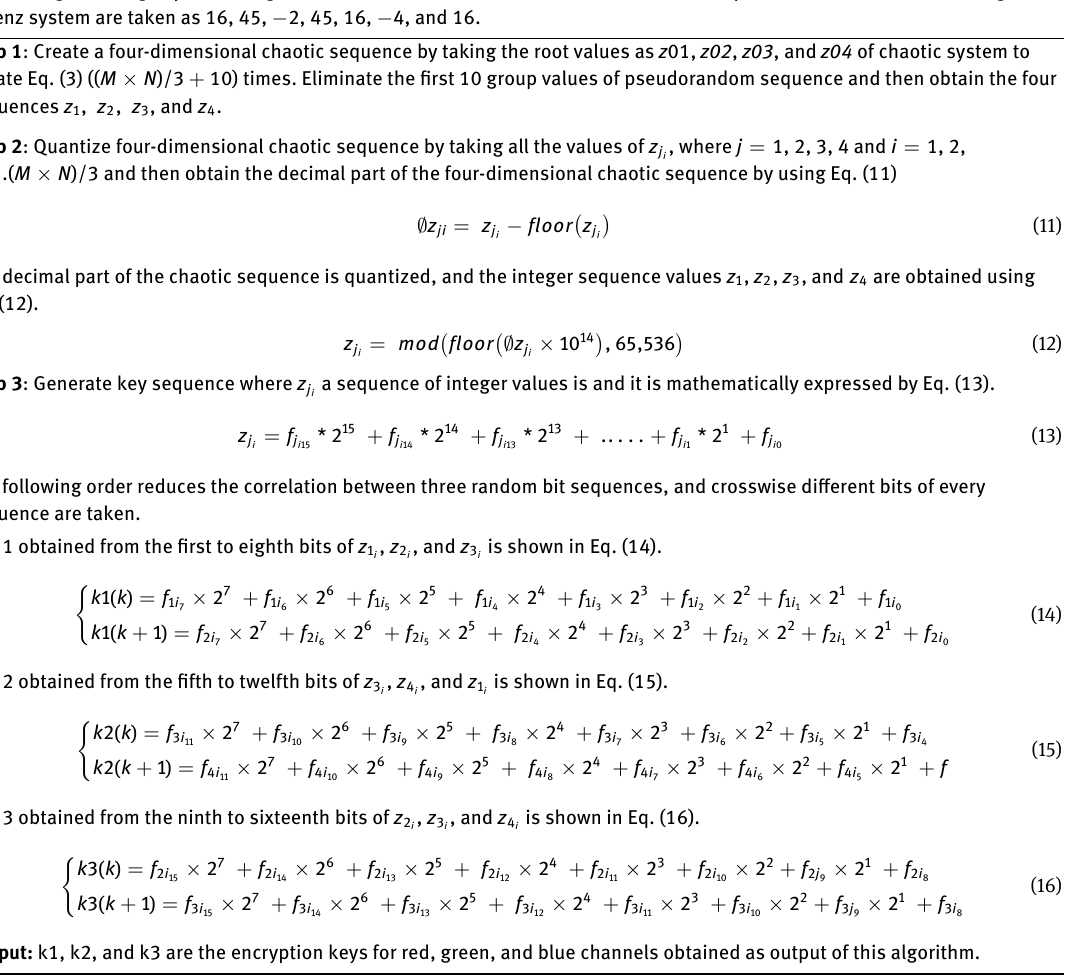
Algorithm 1: Pseudorandom Key Generator Using Lorenz